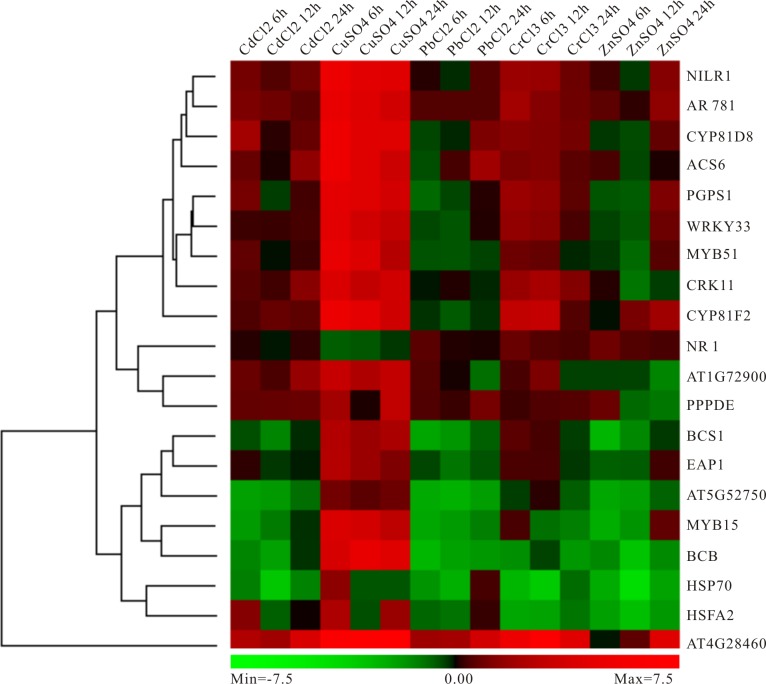
Experimental validation of selected candidate key genes.